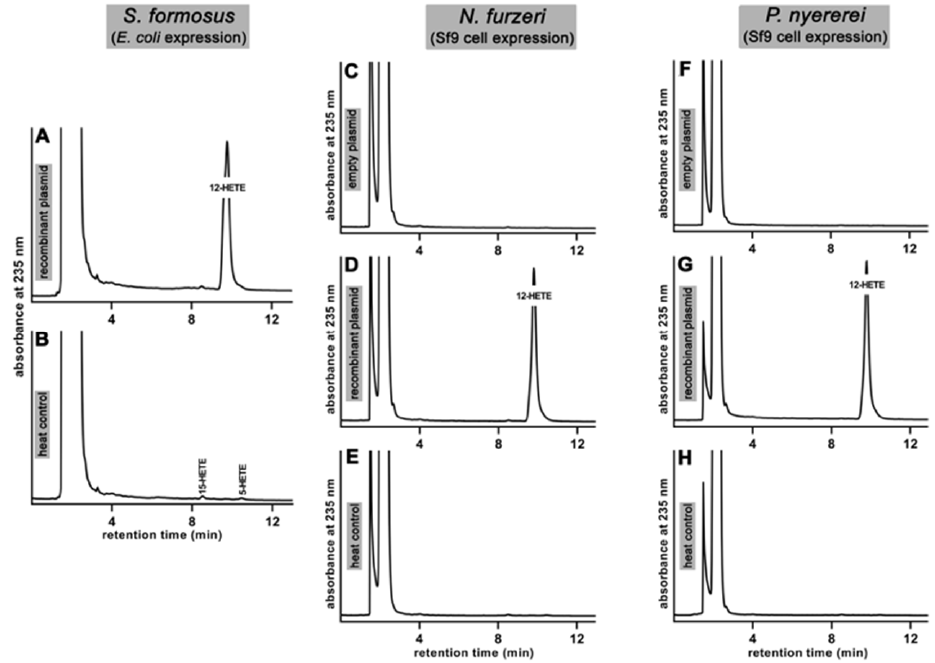
Figure 2. In vitro ALOX activity assays. In vitro ALOX activity assays (see Section 4) were carried out using aliquots of the cellular lysates as enzyme source. The reaction products formed from arachidonic acid during a 3 min incubation period were analyzed by RP-HPLC. Conjugated dienes co-eluting with an authentic standard of 12-HETE are detected (panels ( A , D , G )). These products were not formed in two different control incubations [no enzyme controls (addition of PBS instead of cellular lysis supernatant to the activity assay), (panels ( C , F )) and heat controls, (panels ( B , E , H ))]. Since we normalized each chromatogram to the highest peak direct comparison of the amounts of products formed by the different enzymes is not possible.